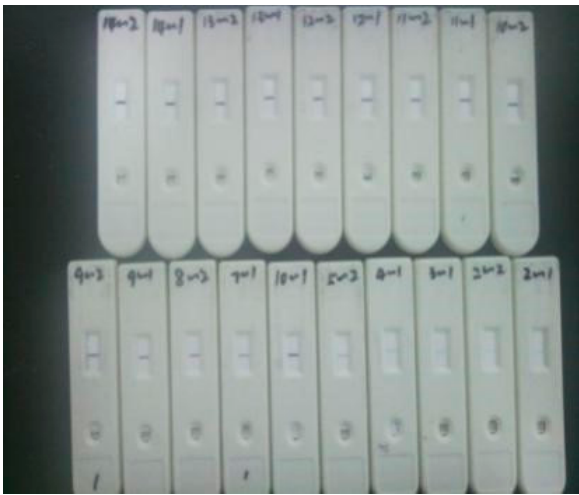
Figure 9. Printed calibration test strips.